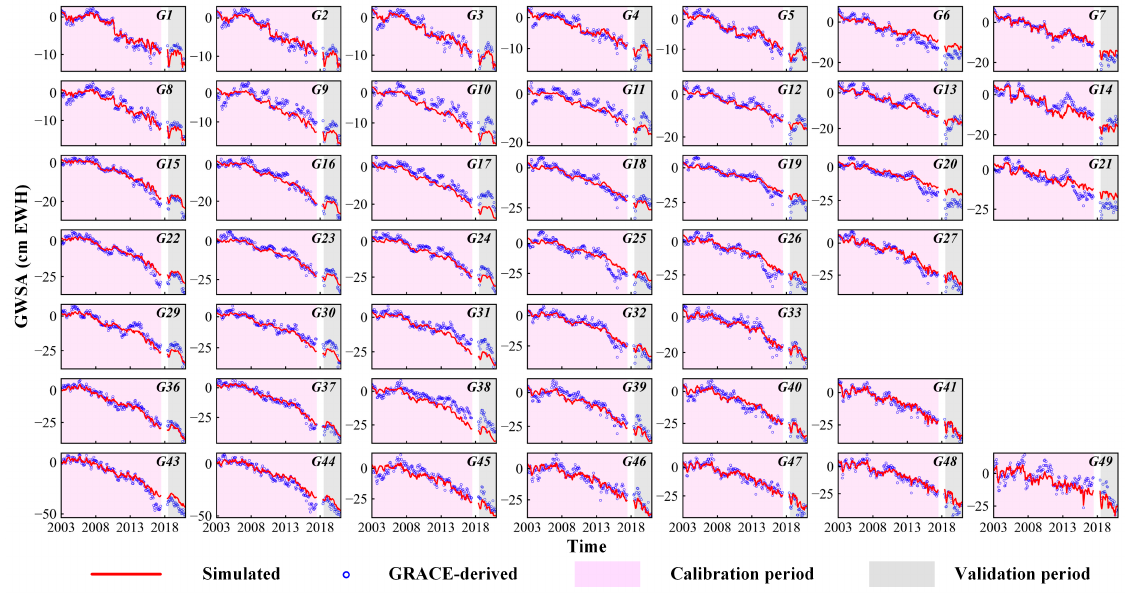
Figure 4. Comparison of GRACE-derived and simulated GWSA for 45 grid cells for both the calibration and validation periods. The pink range is the model calibration period, the gray range is the model validation period, the red lines are the model calculation result, and the blue scatters are the GRACE-derived results.